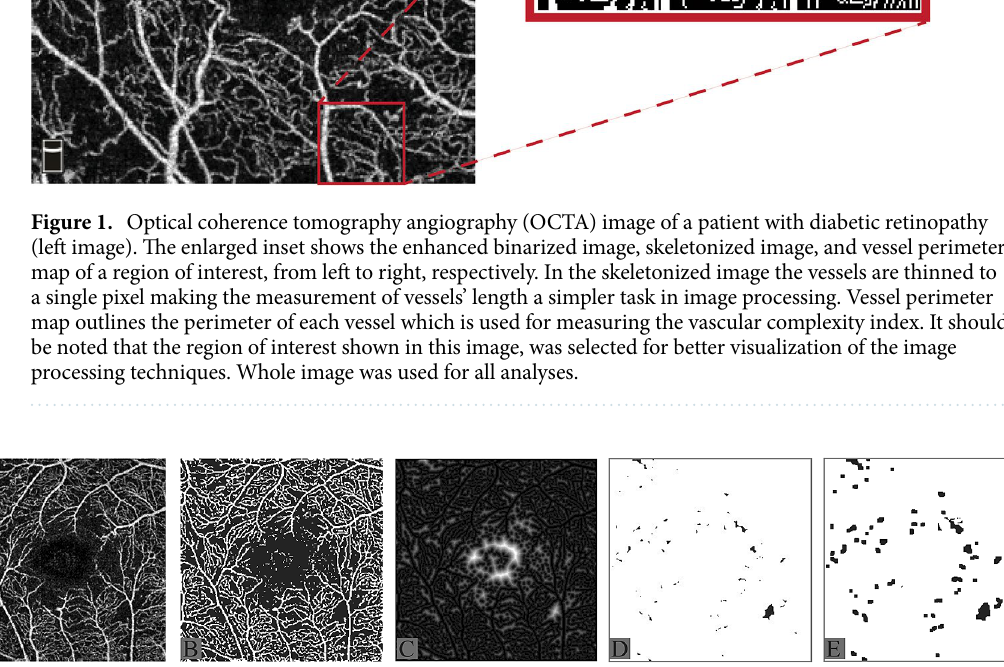
Figure 2. Original enface optical coherence tomography angiography (OCTA) image of a patient with diabetic retinopathy in superficial capillary plexus (SCP) layer (A) . The Frangi vesselness filter is applied and the image is binarized (B) . The vessel distance map (C) is generated to show the distance of each pixel from the nearest vessel. This map is then thresholded (D) to eliminate the areas related to normal inter-capillary distance. Finally, after applying morphological filters based on previous experience in a normal database, capillary nonperfusion (E) area (dark pixels: 4.07%) is calculated.